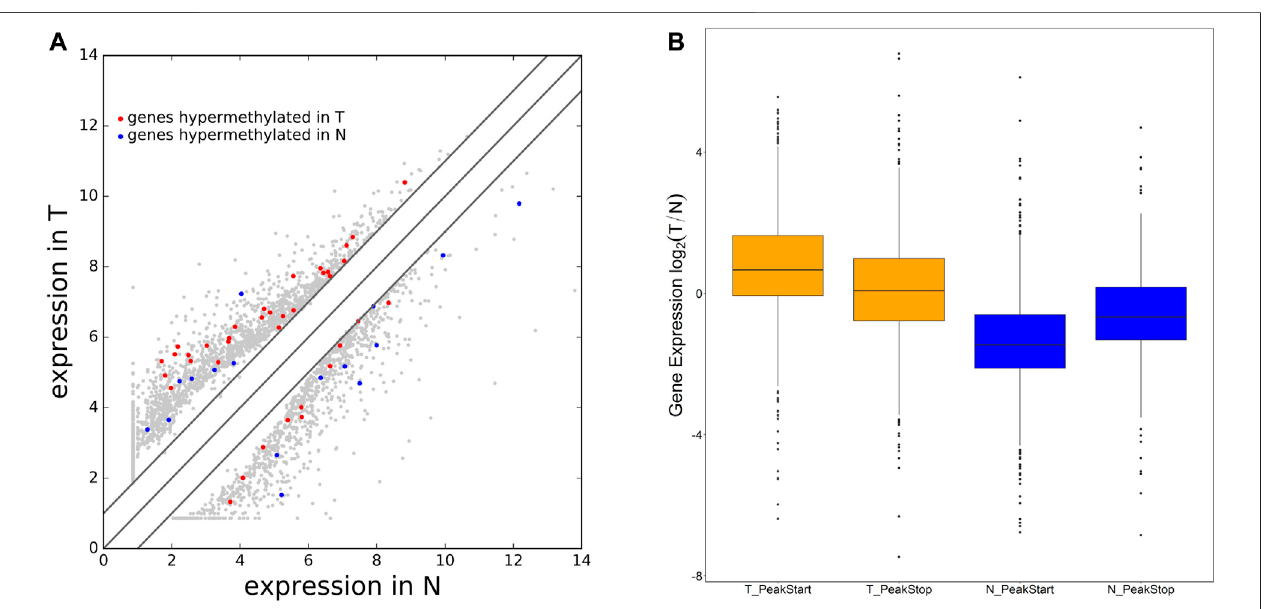
FIGURE 4 | Differential expression mRNA harboring differentially methylated N 6 -methyladenosine sites. (A) Differentially expressed mRNA in AEG and matched normal tissue. (B) The ratio of mRNA expression levels in two samples containing tumor/normal-speci fi c m 6 A peaks.